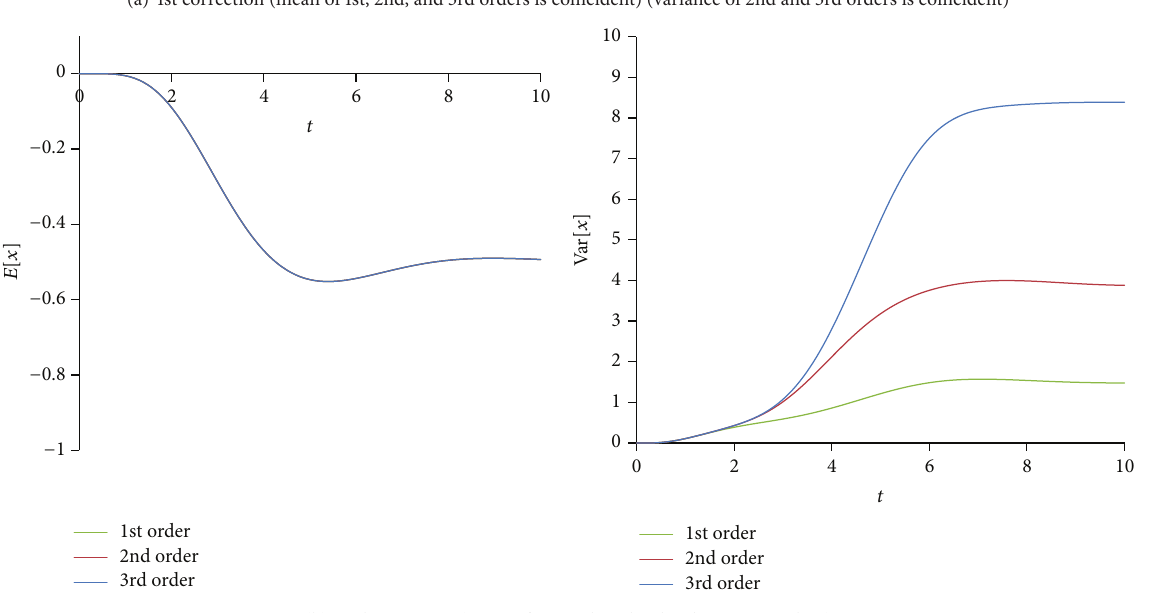
Figure 14: Comparison between the response mean and variance for the first, second, and third orders with numbers of corrections 1 and 2, 𝜀 = 1.0 .